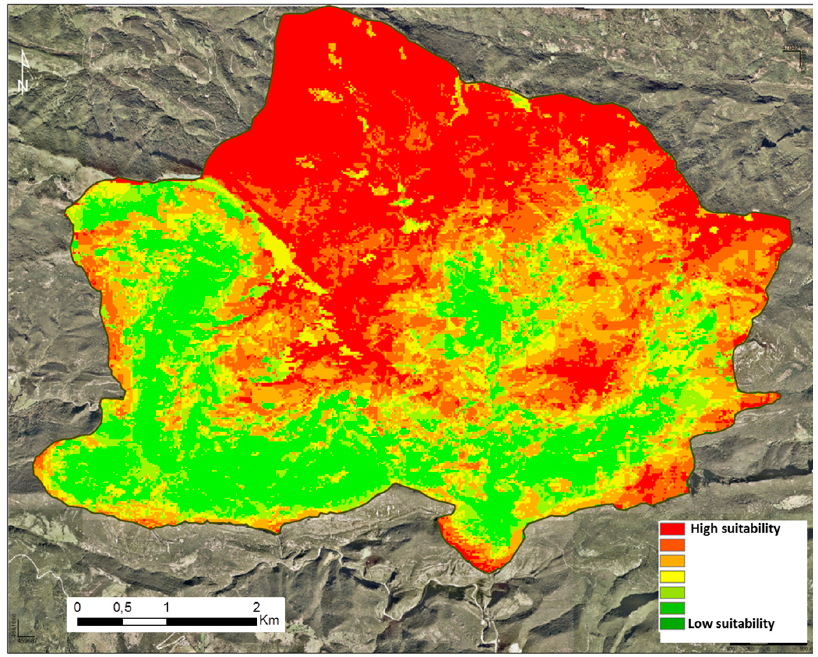
Figure 6. Suitability map according to the neutral matrix (Scenario 2).